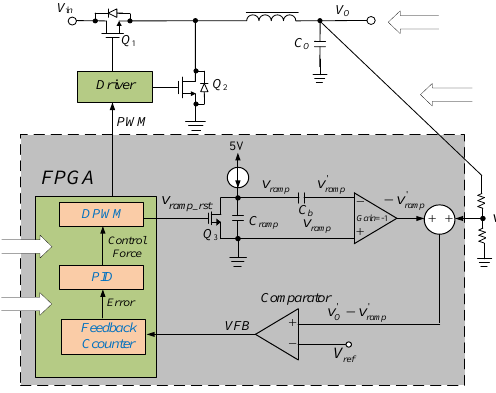
Figure 3. System configuration. Figure 3. System